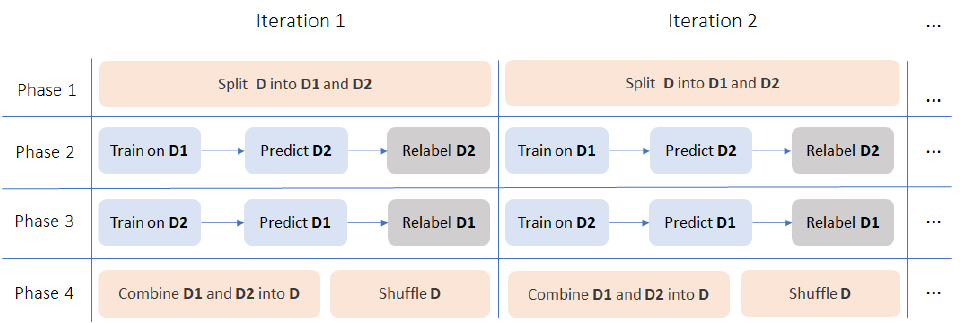
Figure 5: Proposed iterative